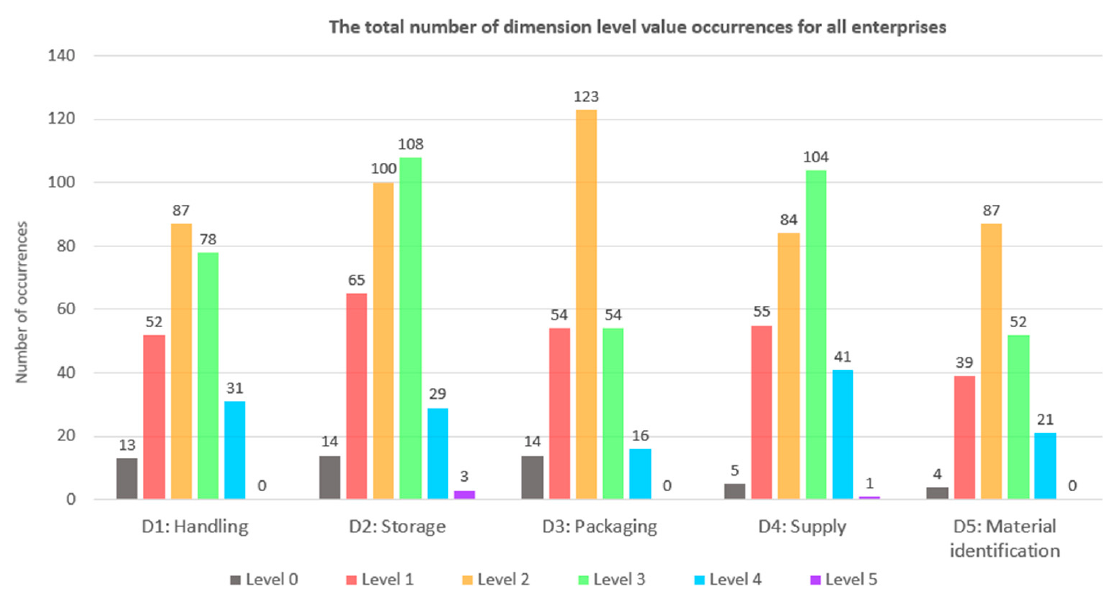
Figure 5. The total number of dimension level value occurrences for all enterprises .